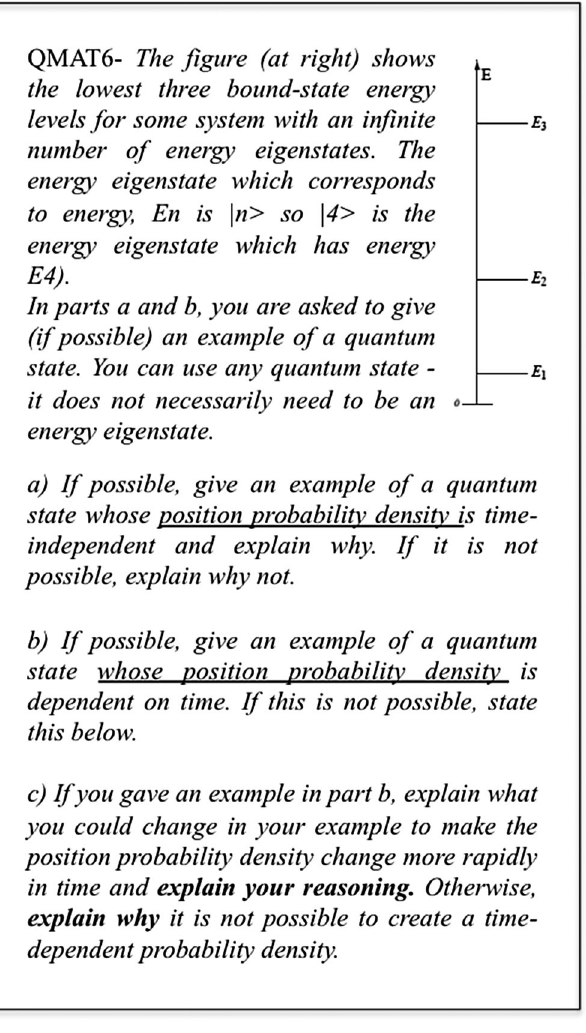
FIG. 3. Original open-ended QMAT question